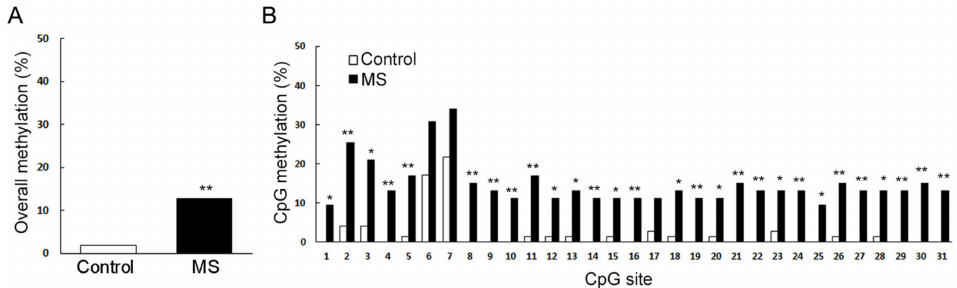
Figure 2. Methylation patterns across Drd1a CpG islands in female maternal separation (MS) mice. ( A Overall methylation is presented as the percentage of methylated sites (n = 9 for control, n = 8 for MS; p < 0.0001). ( B ) Individual CpG methylation statuses are presented as the percentage of methylated sites ( n = 9 for control, n = 8 for MS; 31 CpG sites). * p < 0.05, versus control; ** p < 0.01, versus control (Fisher’s exact test)